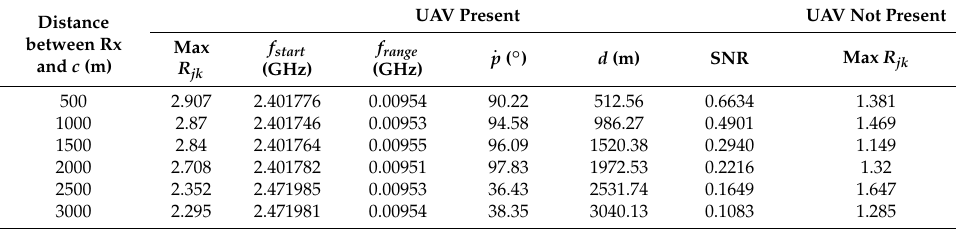
Table 1. Estimated parameters with the proposed method in an outdoor environment. UAV: unmanned aerial vehicle; R jk : improved cross-correlation matrix; f start : the start of the UAV signal; f range : the range of the UAV signal; p : estimated direction of arrival; d : the distance between the source and receiver; SNR: signal-to-noise ratio.